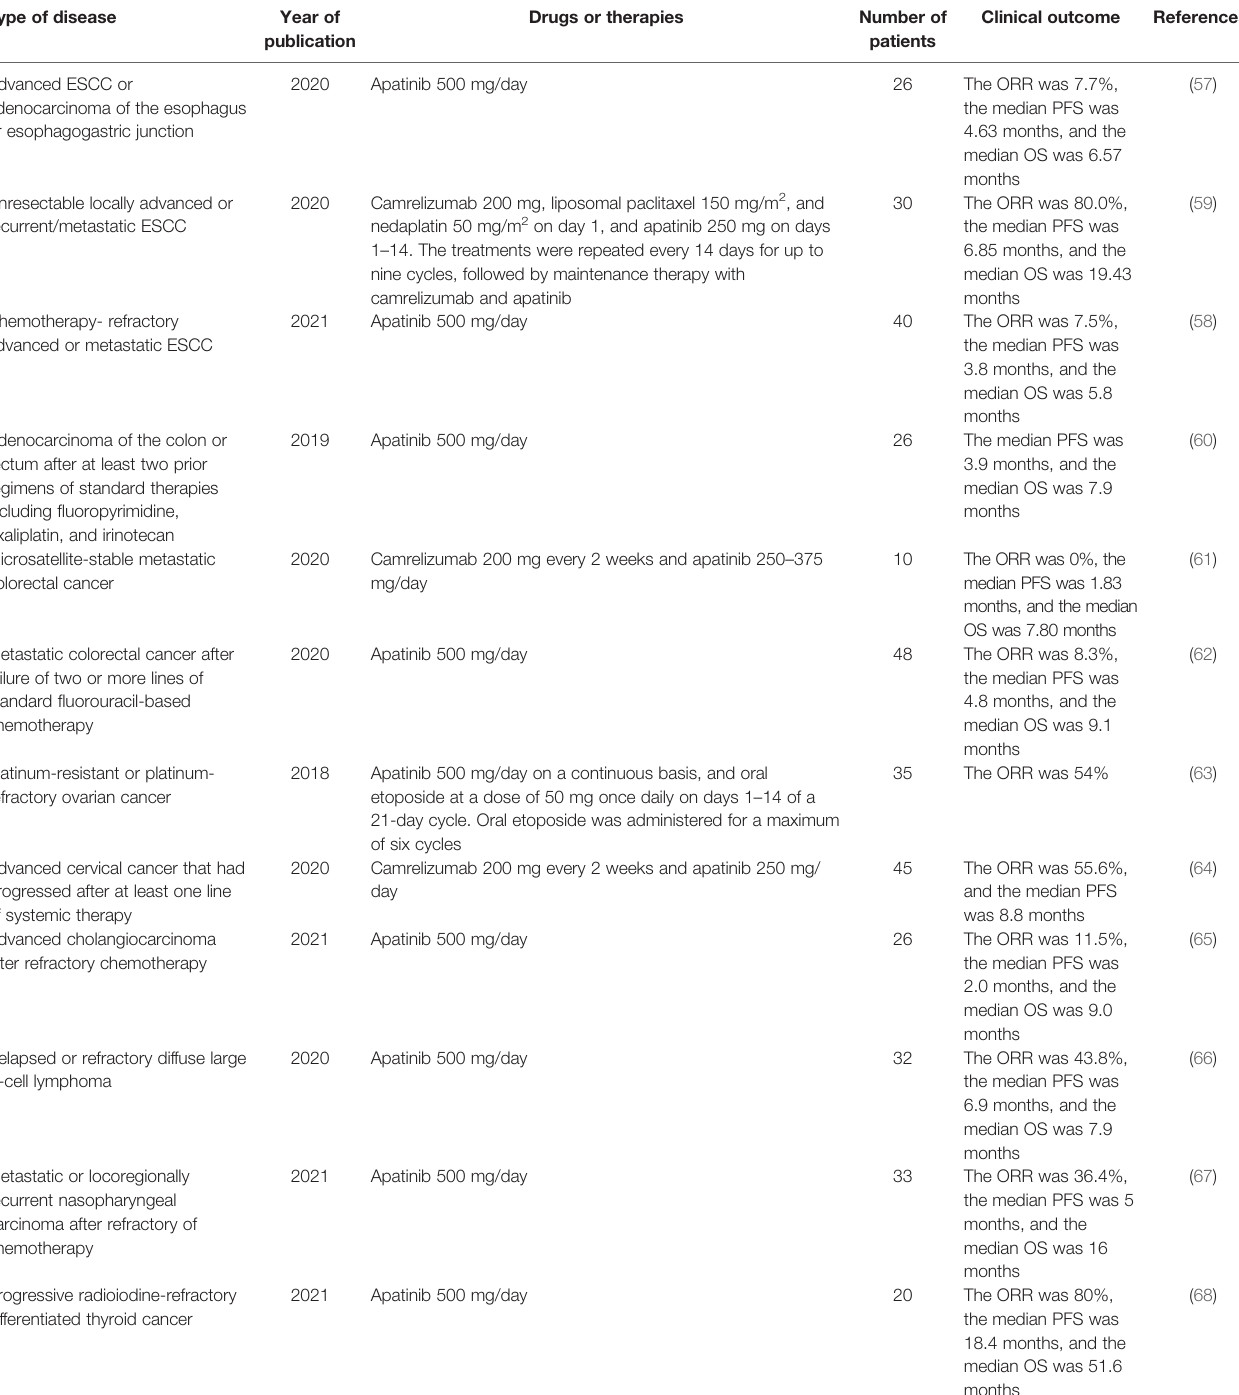
TABLE 6 | Clinical trials on apatinib for the treatment of malignant tumors included in this